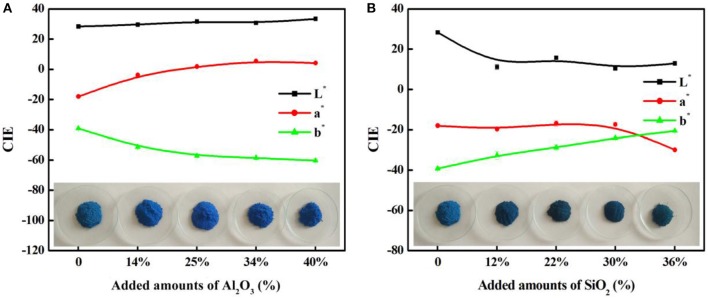
The relationship between the CIE parameters of CoAl2O4 hybrid pigments prepared after incorporating of different added amounts of (A) Al2O3 and (B) SiO2 without clay minerals, respectively.